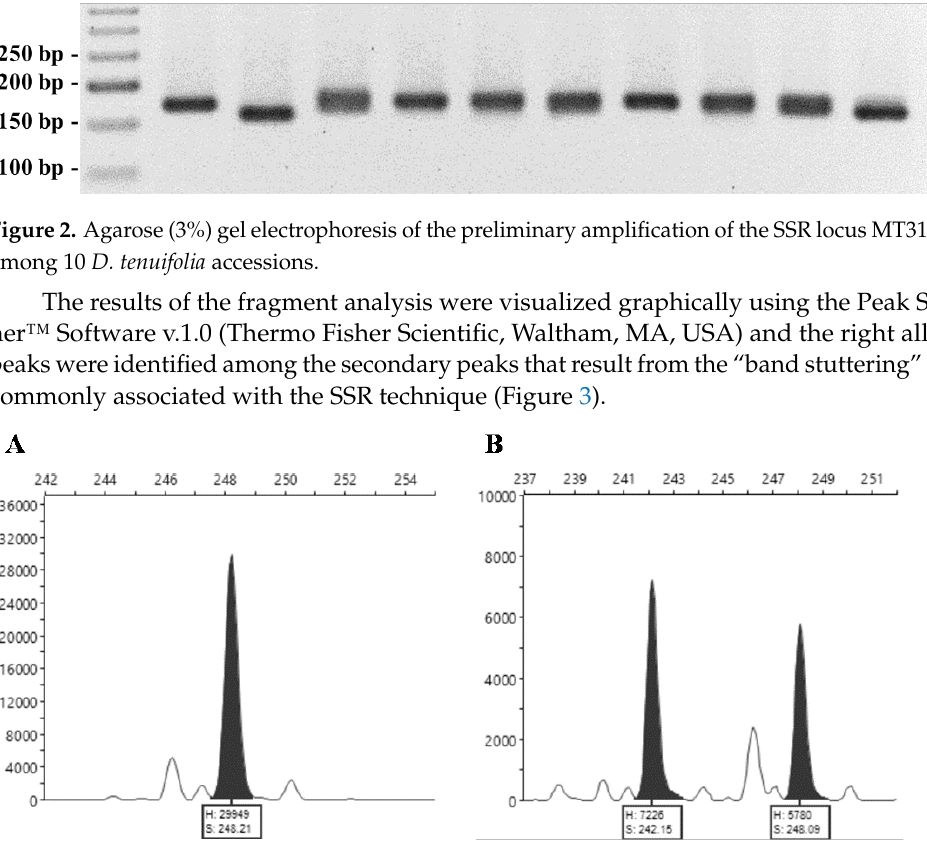
Table 1. SSR Loci Used for Accessions Identification.